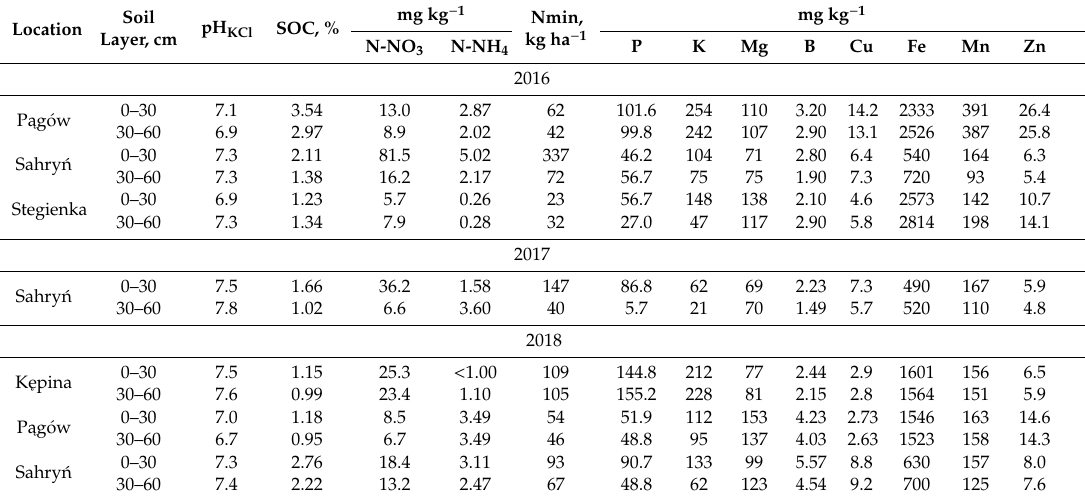
Table 1. Soil conditions before establishing the experiment with sugar beet (2016–2018).